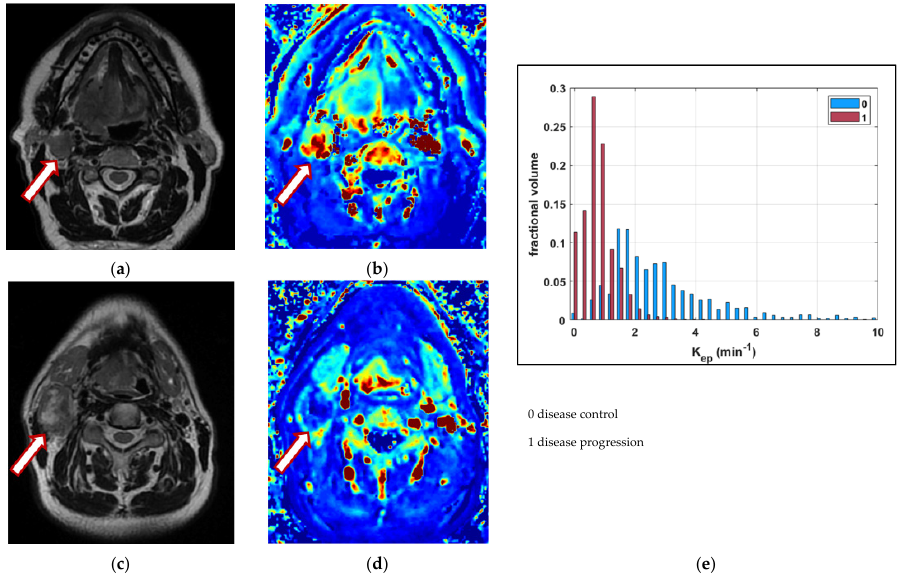
Figure 1. A case of a 69-year-old male patient affected by a carcinoma of the base of the tongue, with disease control. T2-weighted image ( a ) and the corresponding K ep map ( b ) show a solid and well- perfused pathologic lymph node in the right cervical region (indicated by the arrow); at the bottom, a case a 60-year-old male patient affected by a carcinoma of the base of the tongue, without disease control. T2-weighted image ( c ) and the corresponding K ep map ( d ) show a large and necrotic lymph node. The comparison of the K ep distribution in the entire N volume for the patients with and with- out disease control is depicted ( e ).